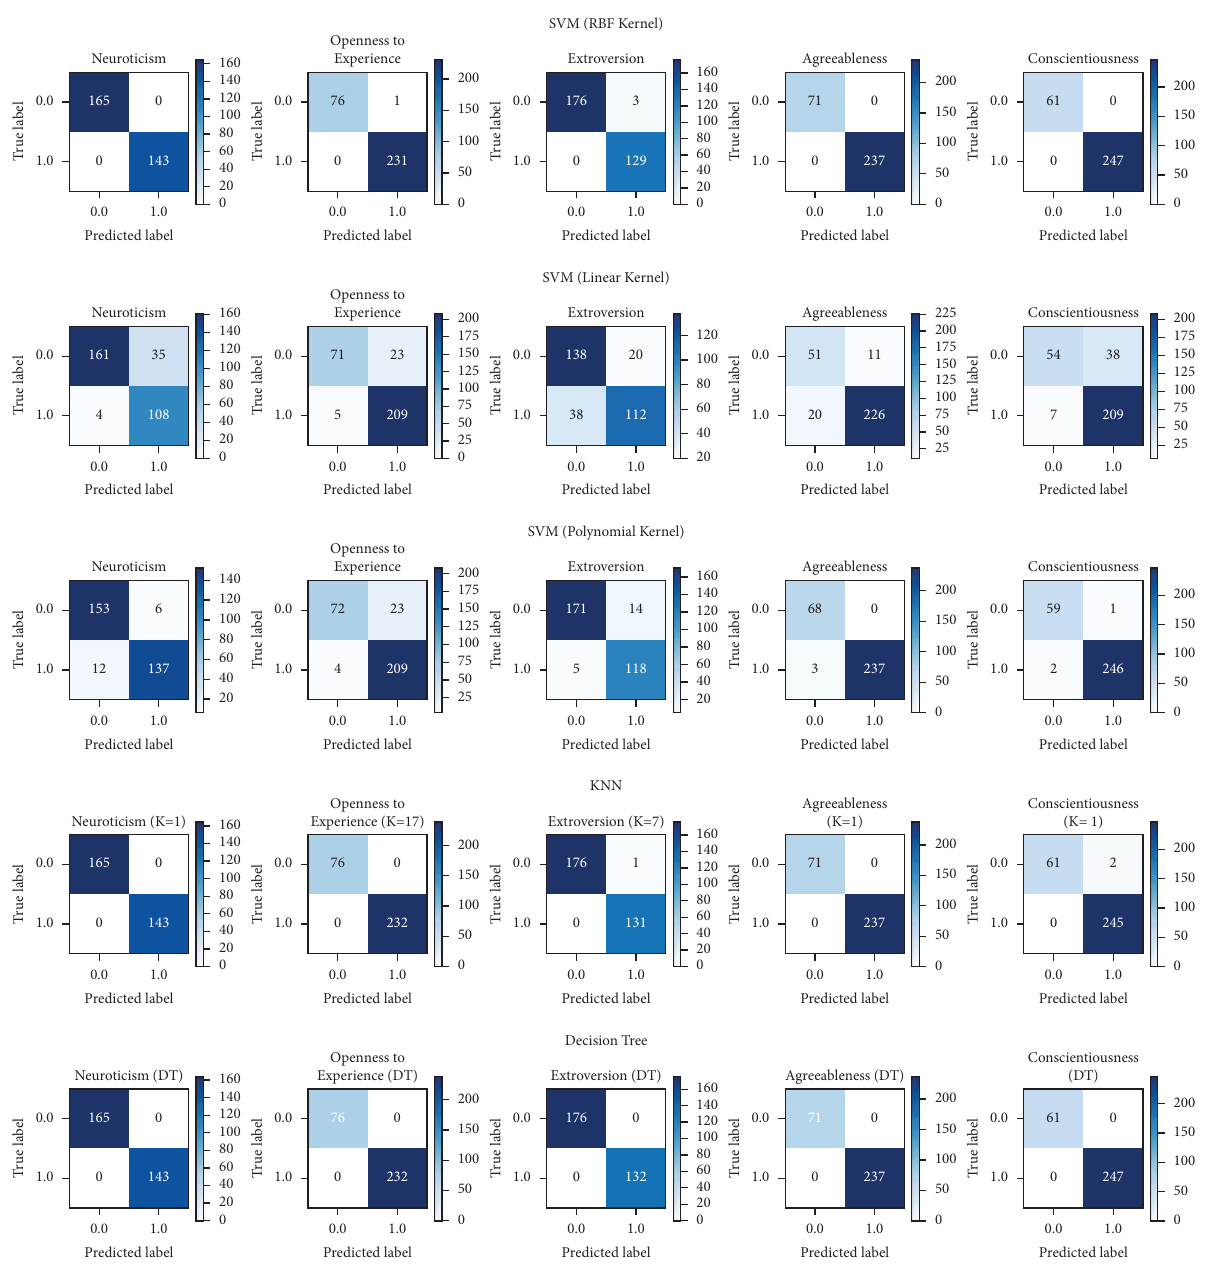
Figure 3: Confusion matrix for each